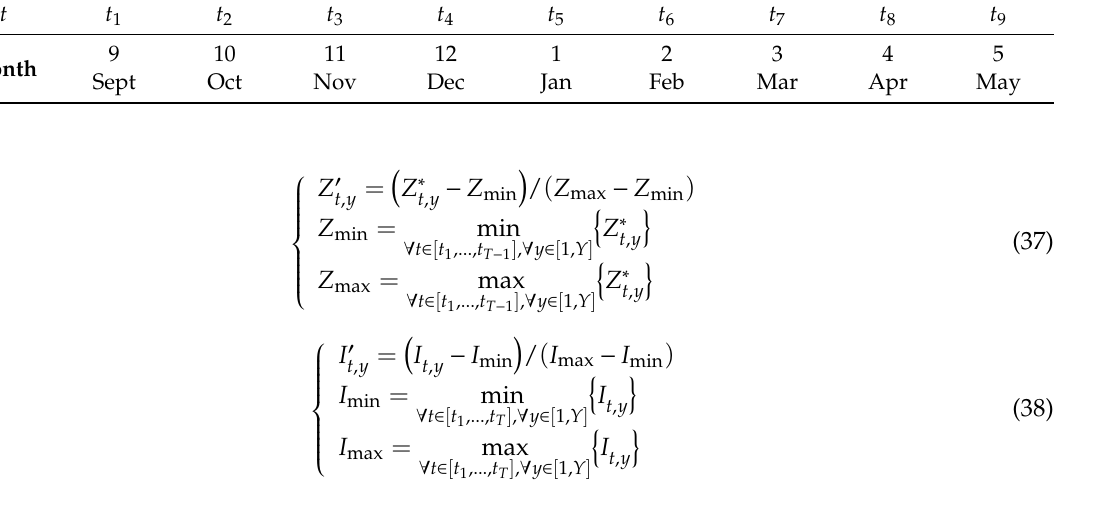
Z } for 55 years from I } and the optimal control water level process { * After the inflow sequence { t t Z } and { I } were preprocessed with Equations (37) and 1959 to 2014 obtained by DP, all the data of { * t t (38) to normalize the influence of each element and avoid the dominant elements whose absolute values are much larger than those of the other attributes.